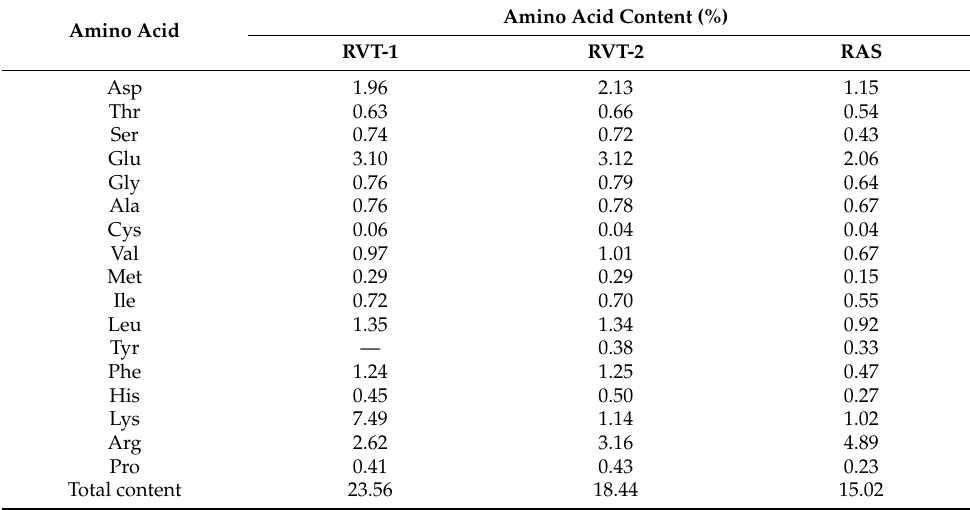
Table 2. Amino acid contents of RVT and